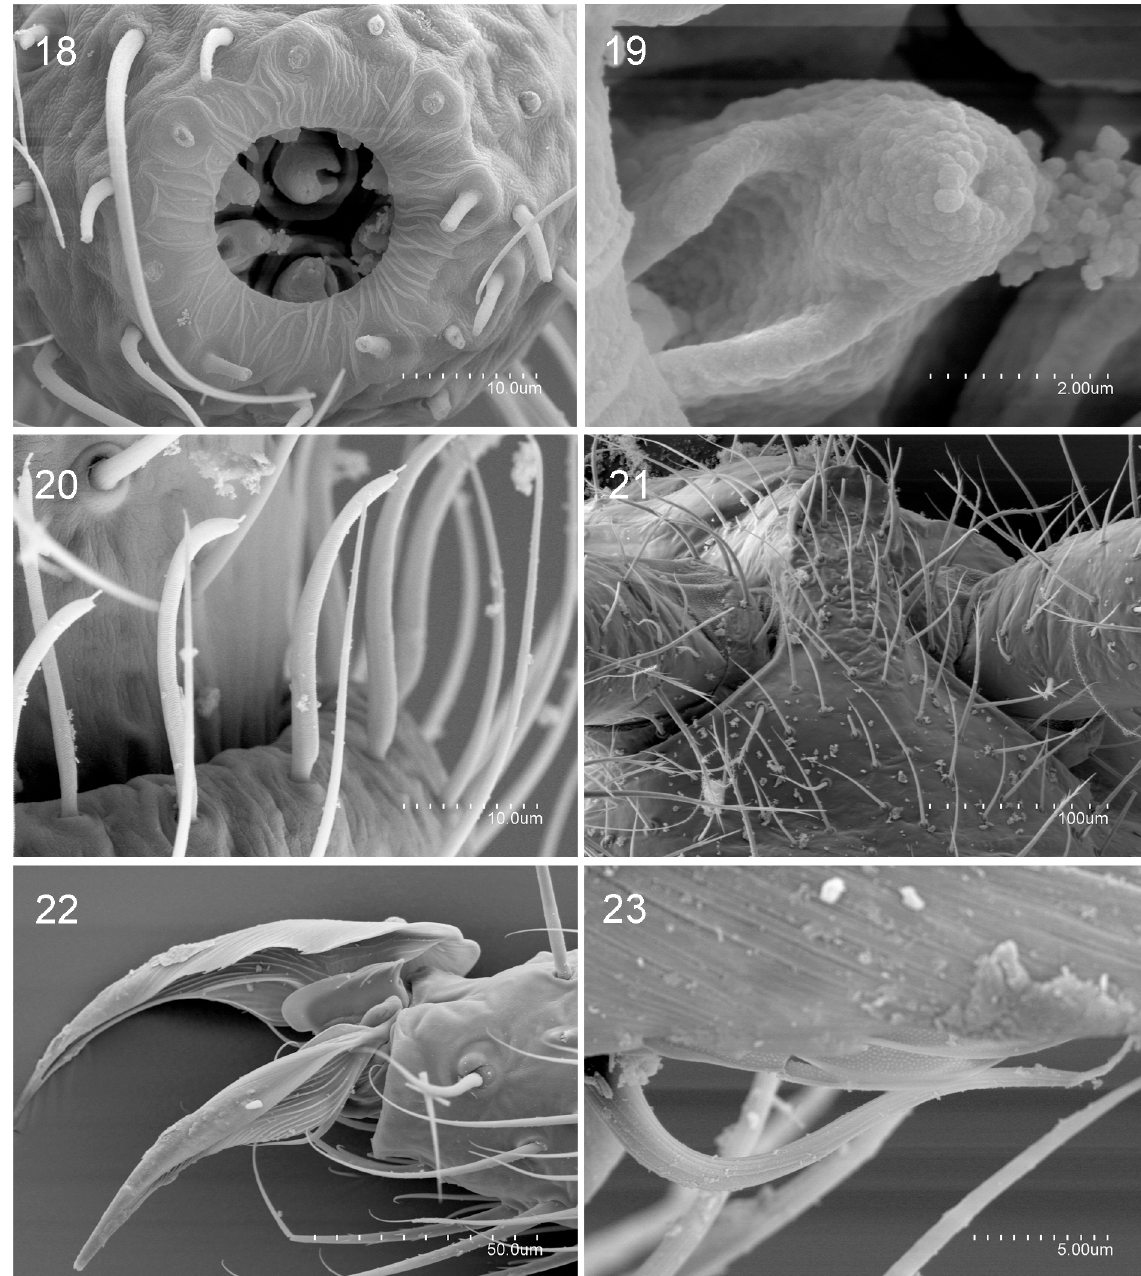
Figs 18–23. Plusiocampa (Plusiocampa) dobati Condé in Dobat, 1975. 18 . Cupuliform organ of the last antennomere. 19 . Central cylindrical structure of an olfatory chemoreceptor sensillum of the cupuliform organ. 20 . Gouge sensilla. 21 . Frontal process. 22 . Telotarsal end of metathoracic leg. 23 . Detail of telotarsal claw. Scale bars in